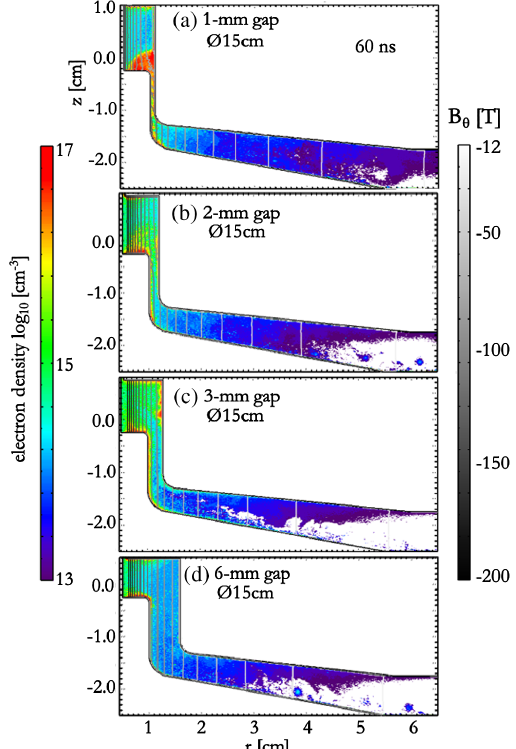
FIG. 8. 2D simulation geometries for the four ∅ 15 cm- convolute inner MITLs identified by their AK gaps at r ¼ z ¼ − 1 cm of (a) 1 mm, (b) 2 mm, (c) 3 mm, and (d) 6 mm. The electron density contours and magnetic field isosurfaces are also plotted in each figure at 60